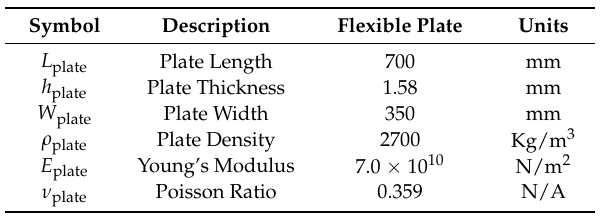
Figure 7. Hardware photograph representing a large flexible structure in experiments.